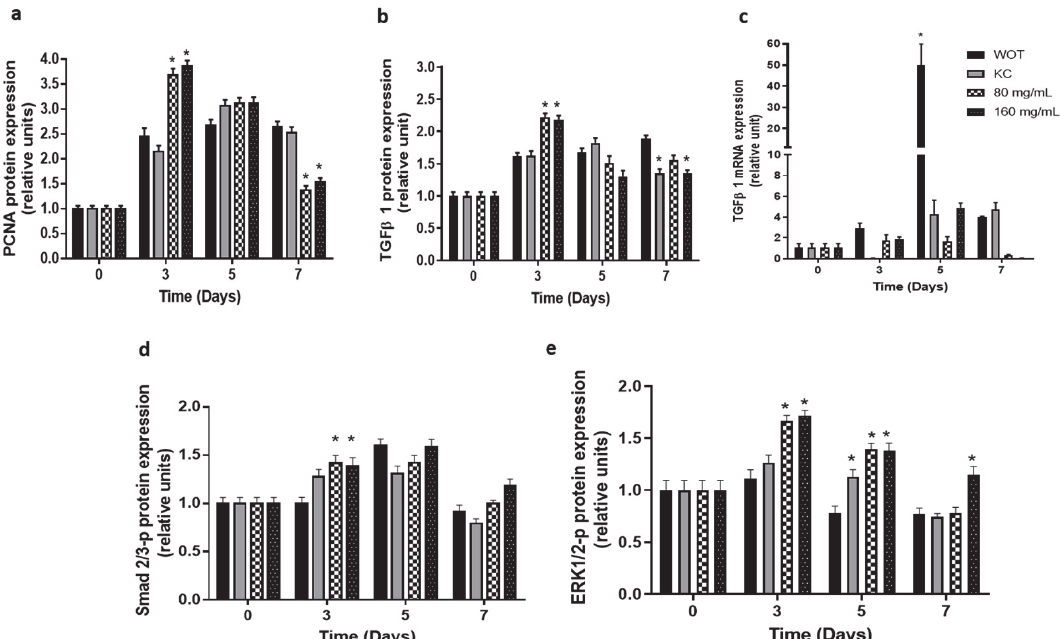
Figure 8. Expression of key regulators of skin wound healing from canonical and non-canonical pathways. ( a ) Proliferating cell nuclear antigen (PCNA) in wound tissue was analyzed by immunohistochemistry. Transforming growth factor beta (TFG β 1) analyzed by ( b ) immunohistochemistry and ( c ) qRT-PCR, respectively, in WOT, KC, and 80 and 160 mg/mL PB -treated groups at different periods of time (0, 3, 5, and 7 days). Phosphorylated ( d ) Smad2/3 and ( e ) ERK1/2 analyzed by immunohistochemistry in WOT, KC, and 80 and 160 mg/mL Bacopa-treated groups at different periods of time (0, 3, 5, and 7 days). Values are expressed as mean ± SEM of at least 6 animals per group; * p < 0.05 versus WOT as indicated by analysis of variance (ANOVA) and post hoc Tukey’s test.